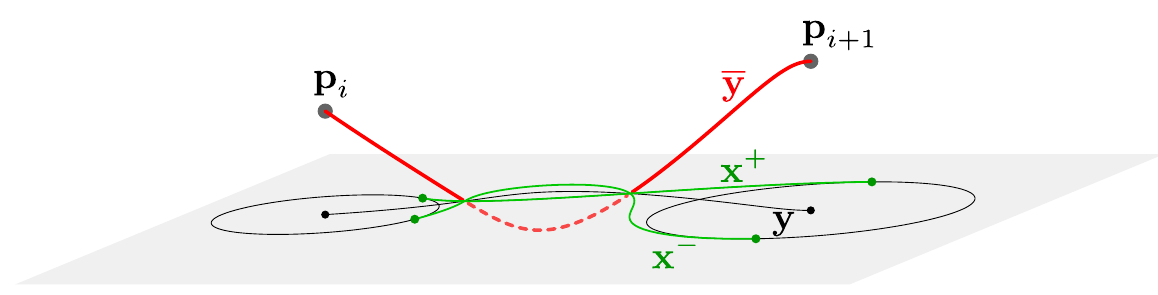
Figure 5. The envelope curves x + , x − , the medial axis y , and the y medial axis transform intersect each other at the same point at the same parameter